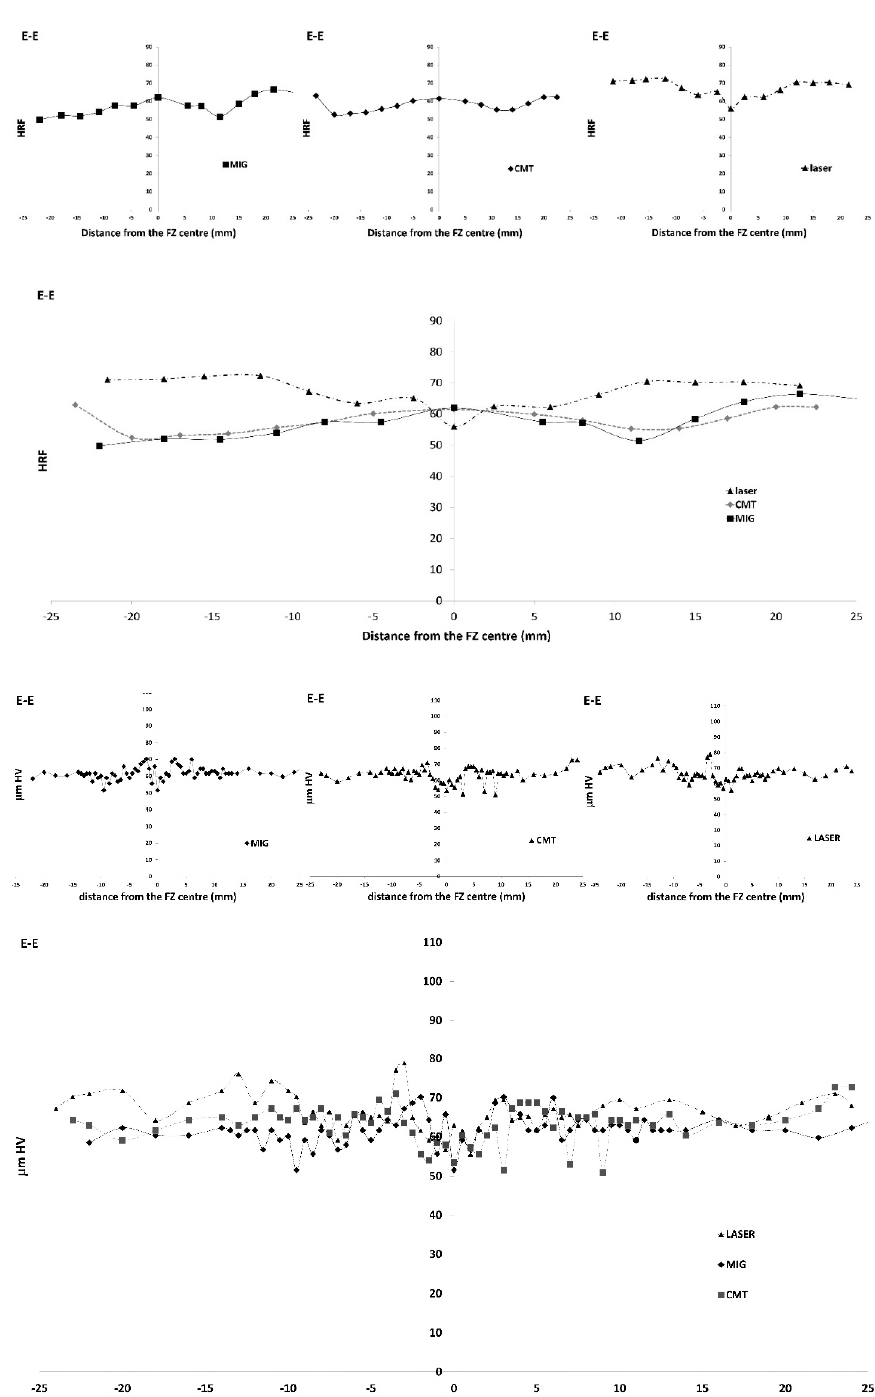
Figure 13. Evolution of the macro-hardness HRF and micro-hardness HV in the E-E combination of the weld for laser, CMT, and MIG.